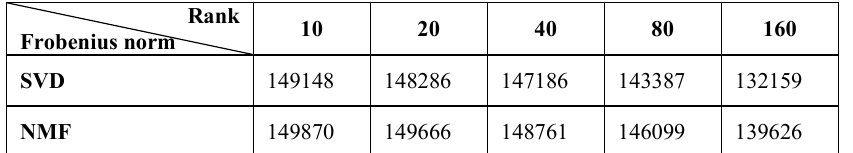
Table 8. Frobenius